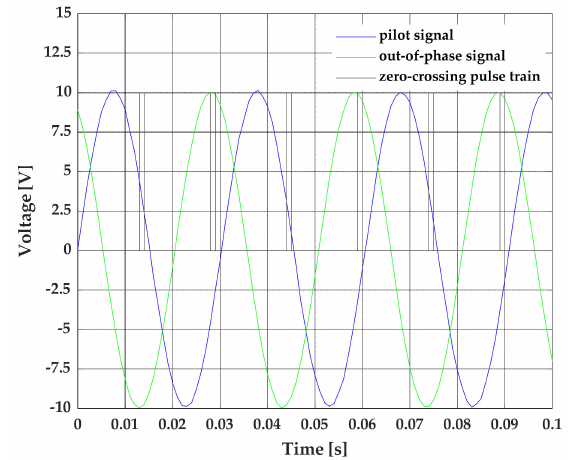
Figure 12. Input signal and logical switch for the RLC